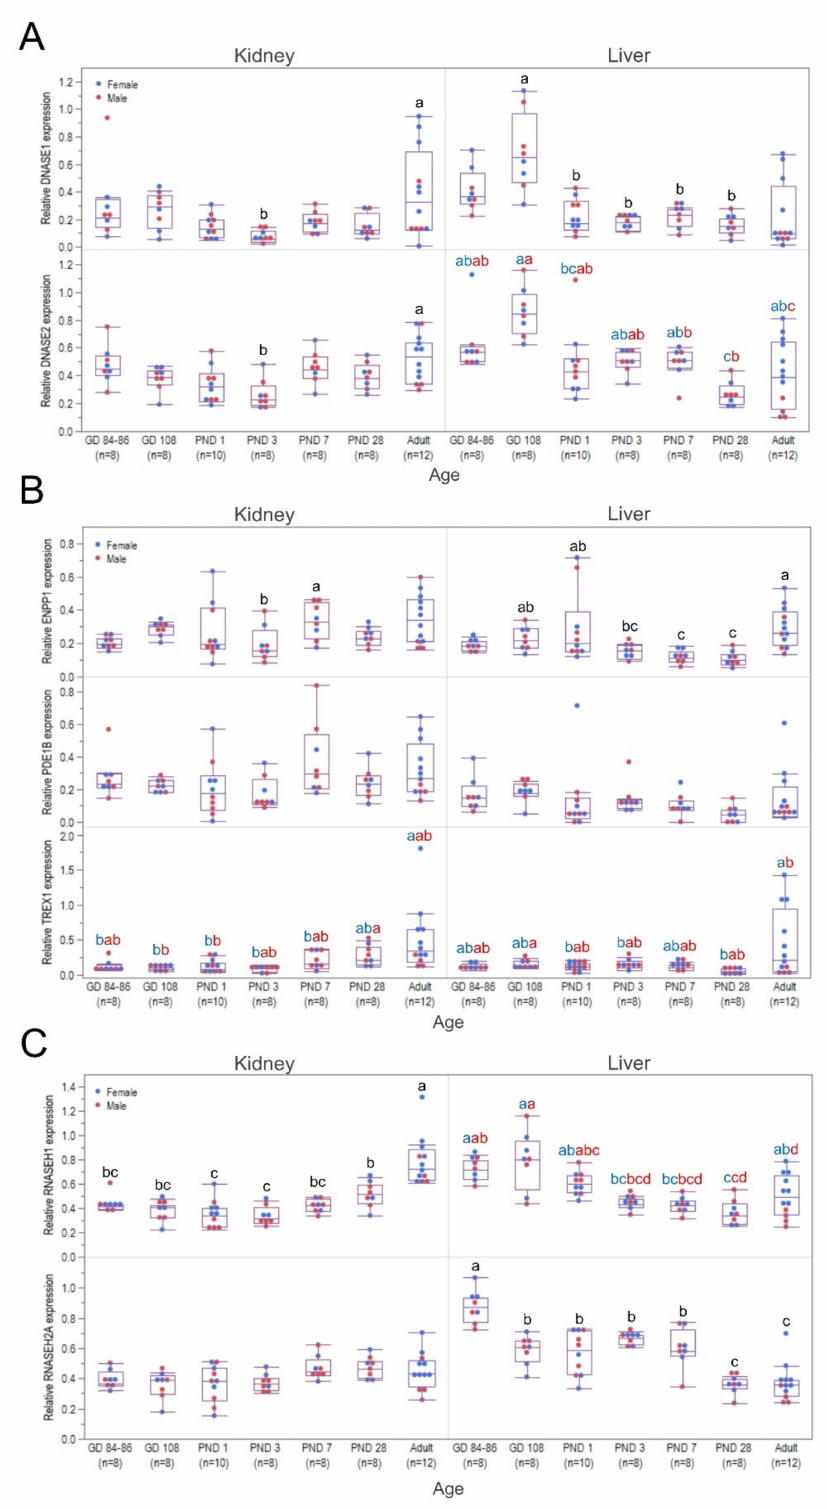
Figure 10. Relative gene expression of nucleases for ASO metabolism and pharmacologic activity over time in the developing and adult Göttingen Minipig. Endonucleases: DNASE1 and DNASE2 ( A ); 3 (cid:48) -exonucleases: ENPP1 , PDE1B , and TREX1 ( B ); and RNASEH1 and RNASEH2A ( C ) were evaluated in kidney and liver. Age groups not connected by same letter are significantly different ( p < 0.05). When sex–age interaction was detected, the gene expression differences between age groups were evaluated separately for females and males. Same colored letters belong to the same sex, and age groups not sharing the same letters are significantly different ( p <